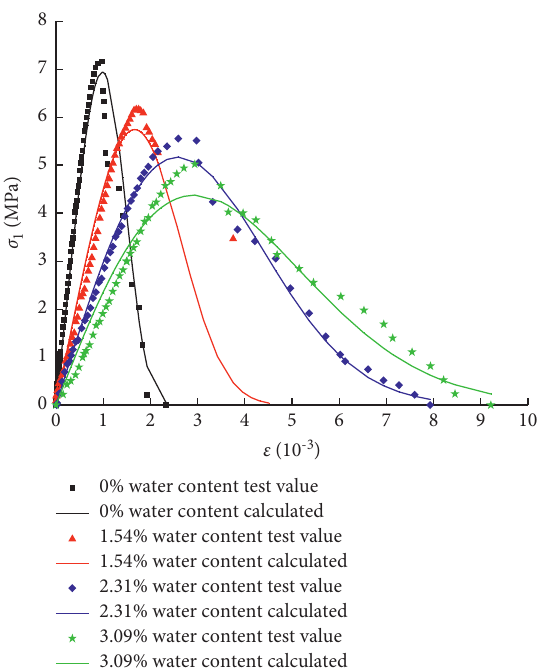
Figure 11: Theoretical and experimental curves under different water contents.